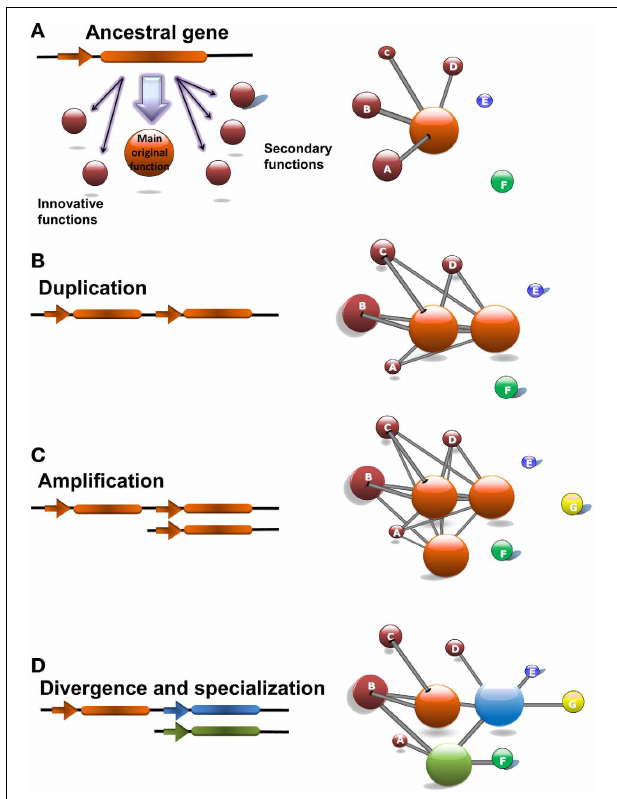
FIGURE 5 | The Innovation-Amplification-Divergence(IAD) model of evolution by gene duplication explains the evolutionary history of the CrCO , PpCOL , and AtCOL genes. (A) The CrCO gene in Chlamydomonas is a hub gene whose main functions are light response and carbon/nitrogen metabolism. Additionally, CrCO presents links to secondary functions such as response to chemical stimulus and developmentalprocesses that can be considered innovations developed by this gene. (B) During the evolution of multicellular land-based plants such as Physcomitrella and Arabidopsis these secondary functions became selectively valuable which facilitated the fixation of duplications of CrCO . Initially, duplicated genes are identical and conserved exactly the same links as the ancestral gene. (C) In order to fully cover the demands exerted by selection of a more complex regulation over developmental processes, an amplification consisting of multiple gene duplications took place, giving rise to the 10 gene family of PpCOLs and the 17 gene family of AtCOLs . (D) After duplication and amplification the same selectively forces facilitate the accumulation of mutations over the duplicated genes that make them diverge, specialize and acquire new functions as it can be observed in the PpCOL and AtCOL genes. This is reflected in the network by the removal of links and the establishment of new ones. Note that in spite of divergence the genes tend to keep links to the main ancestral